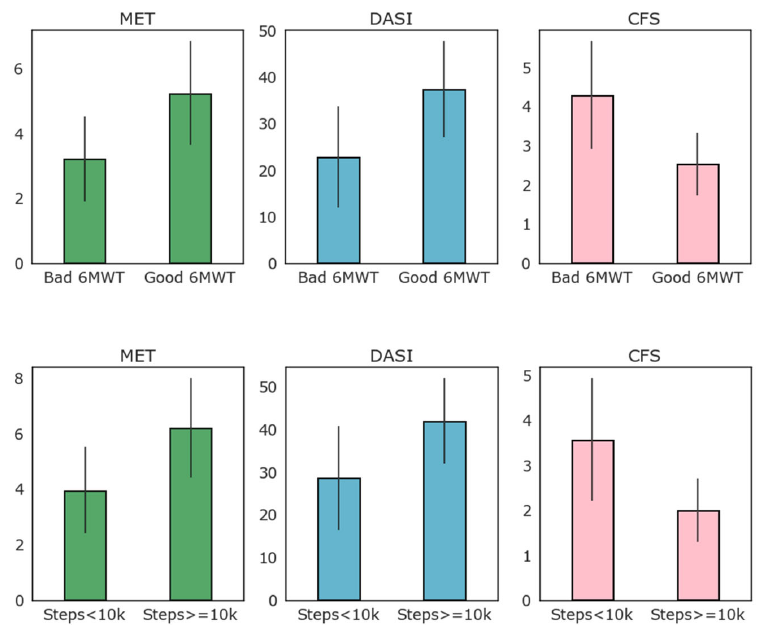
Figure 3. Relation of clinical evaluation scales to low–high performance 6MWT and to high–low average number of steps per day (above or below 10,000 steps per day on average).